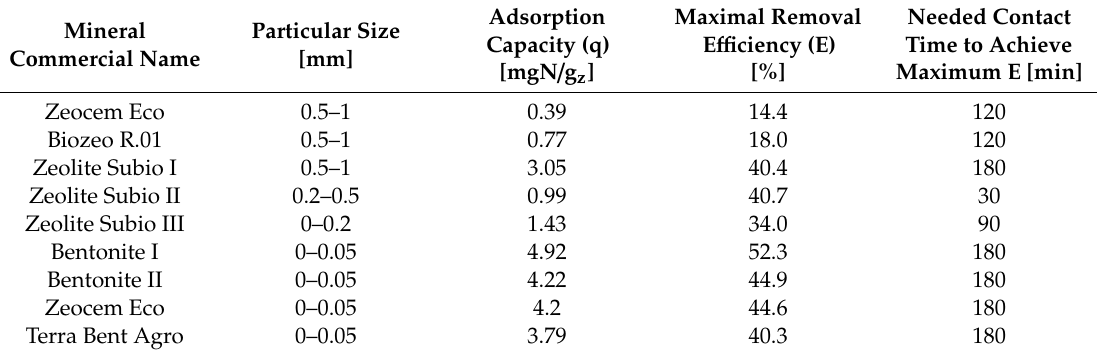
Table 1. E ff ect of using di ff erent sorbents on the NH 4 + adsorption capacity (q) and maximum removal e ffi ciency (E) obtained in performed